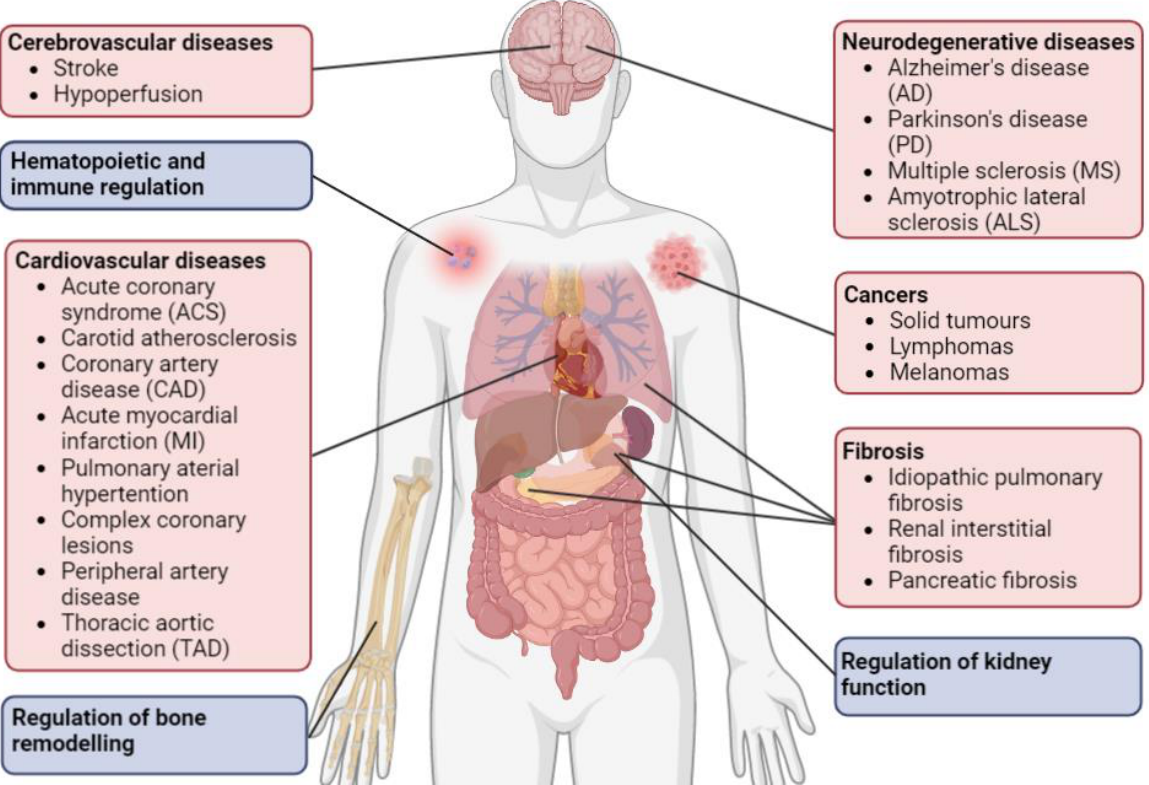
Figure 2. Illustration of the involvement of legumain in various physiological processes (blue boxes) and diseases (red boxes) in different organs and tissues of the body. See the main text for description and references. Created by BioRender.